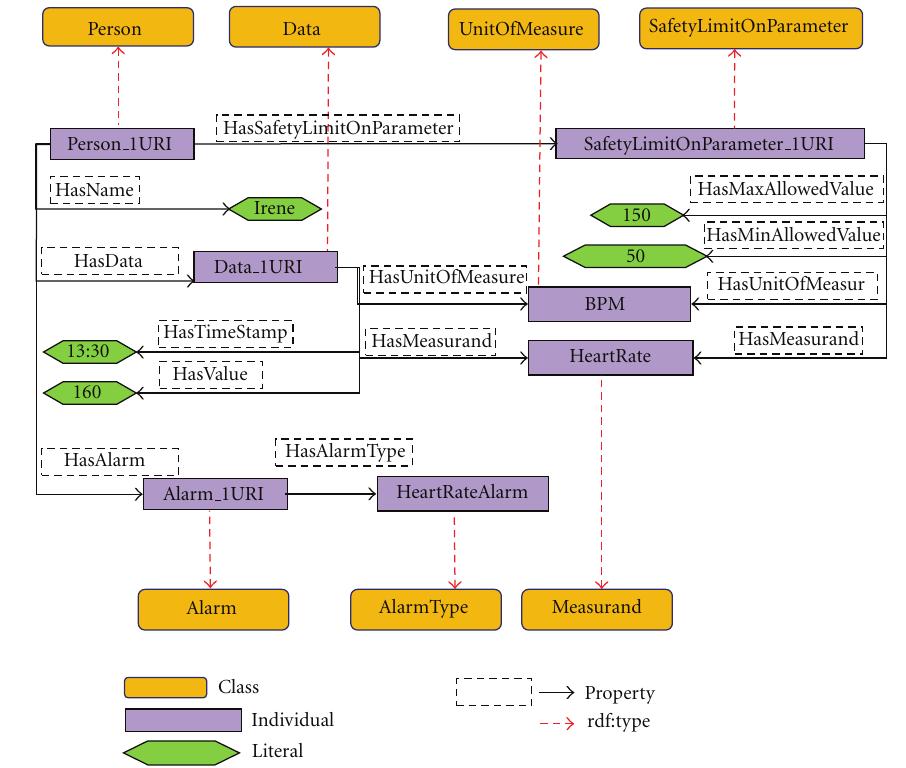
Figure 4: Example of a subgraph shared in the